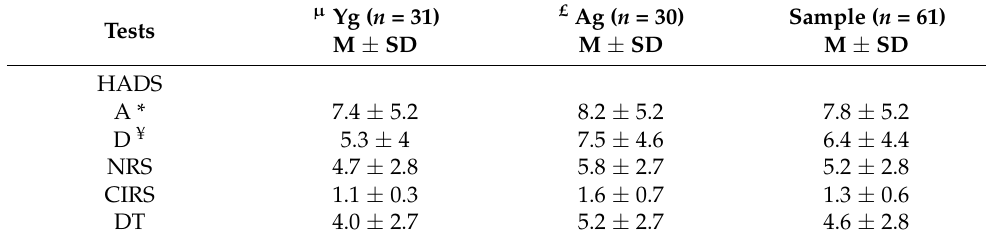
Table 2. Raw scores of psychological testing by age groups.